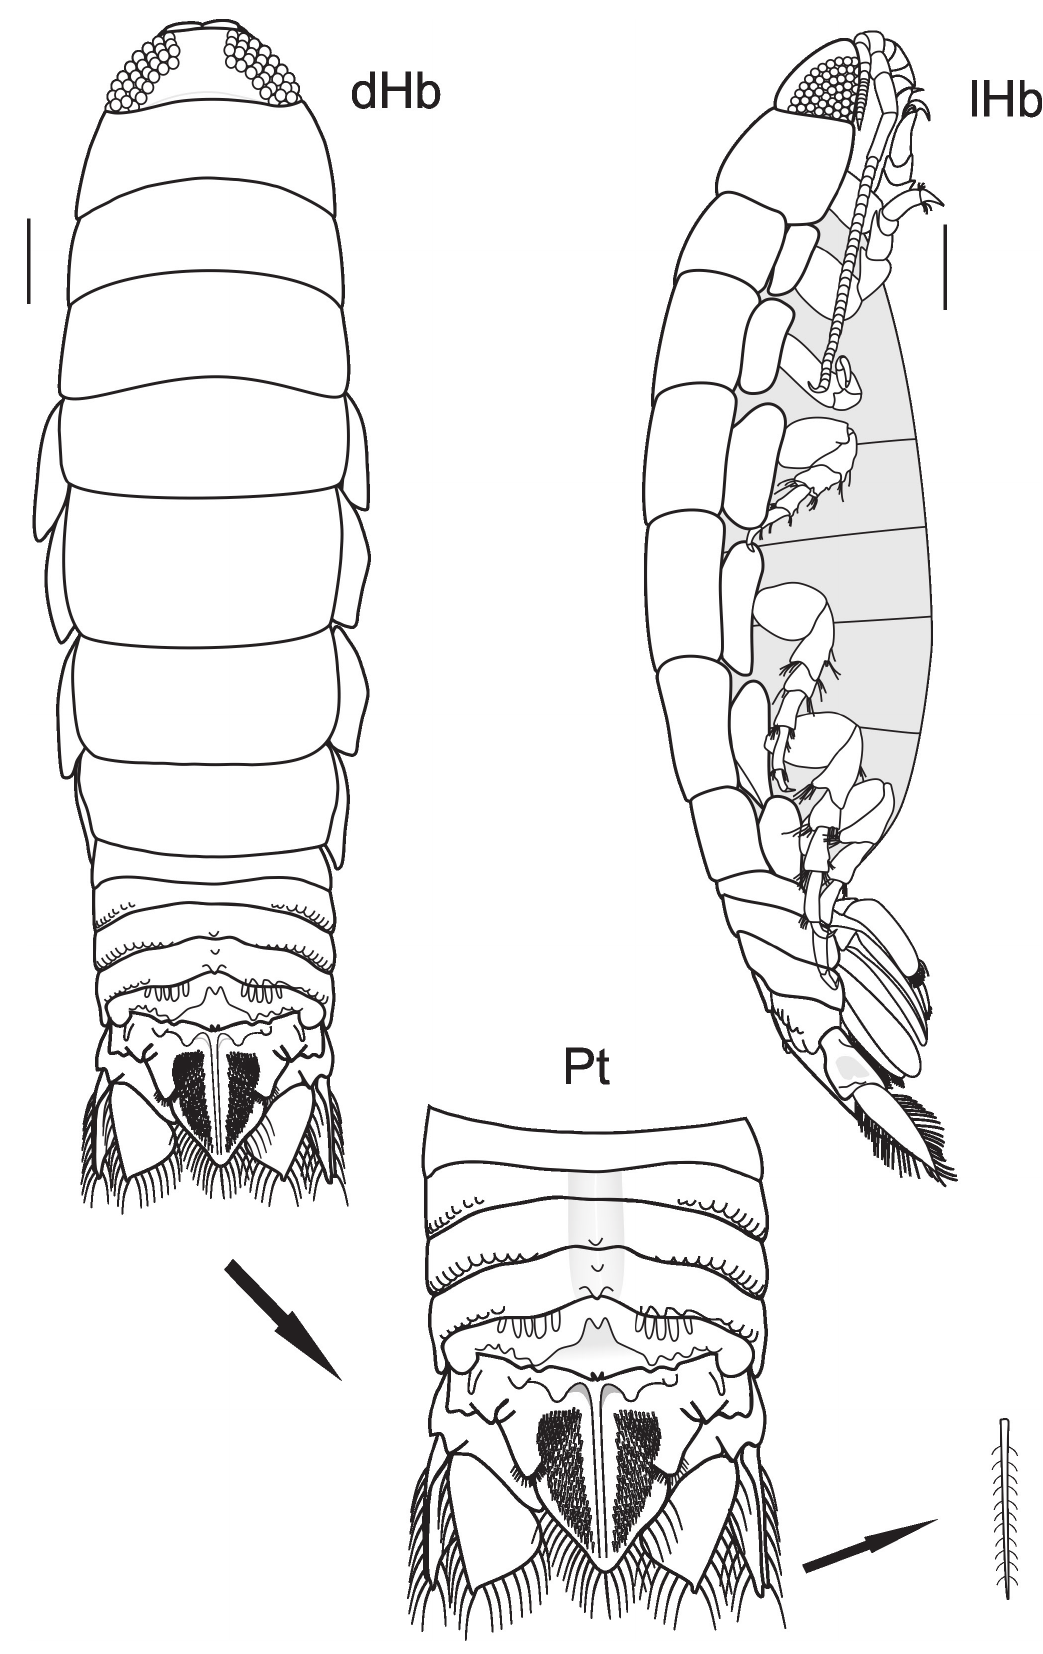
Figure 5. Excorallana lemoscastroi sp. nov., holotype, ovigerous female, 22 mm. (MOUFPE 870), habitus, lateral view and pleotelson detail. Scale = 1